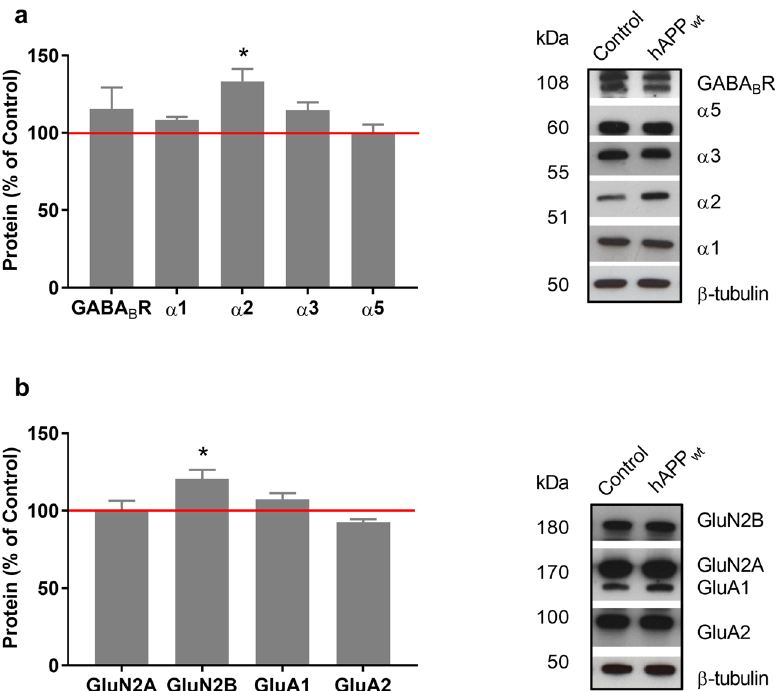
Figure 7. Protein levels of the main GABAergic and glutamatergic receptors in 6 month old male hAPP wt mice. ( a ) Quantification and representative western blots of GABAergic receptor protein levels, including GABA B R and GABA A R α1, α2, α3 and α5 subunits, measured in hippocampal tissue lysates of hAPP wt (n = 4) and control (n = 4) animals. ( b ) Quantification and representative western blots of glutamatergic receptor subunits of NMDA receptor (GluN2A, GluN2B) and AMPA receptor (GluA1, GluA2) measured in hippocampal tissue lysates of hAPP wt (n = 4) and control (n = 4) animals. Protein amount was normalized to β-tubulin and expressed as percentage (Values are means ± SEM; *P ≤ 0.05, two-tailed unpaired t-test with Welch’s